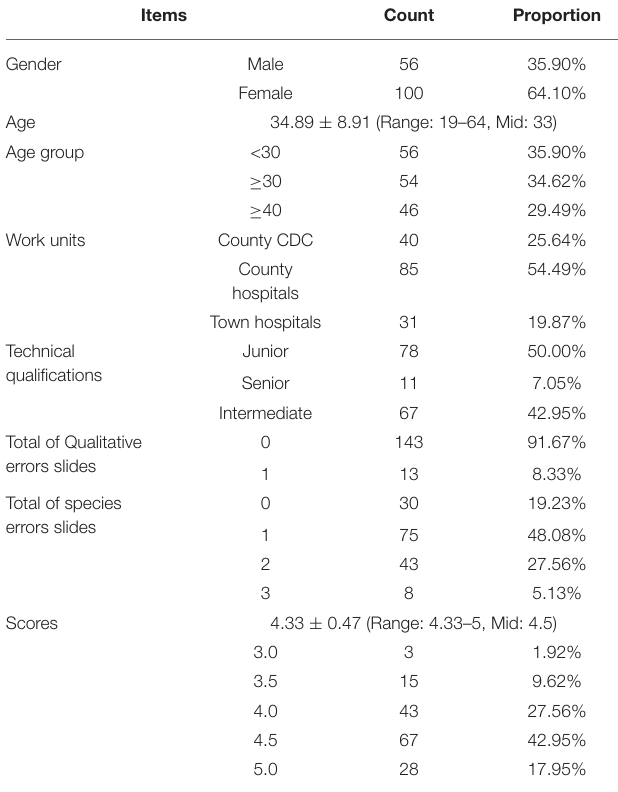
TABLE 1 | Summary of the subjects.